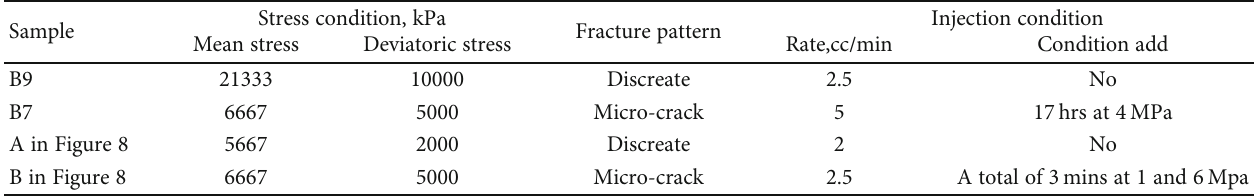
Figure 11: Initial stress condition of di ff erent test samples with respect to a material strength line plotted on Drucker-Prager (i.e., deviatoric stress vs. mean stress) Table 2: Summary of relevant test conditions and results.